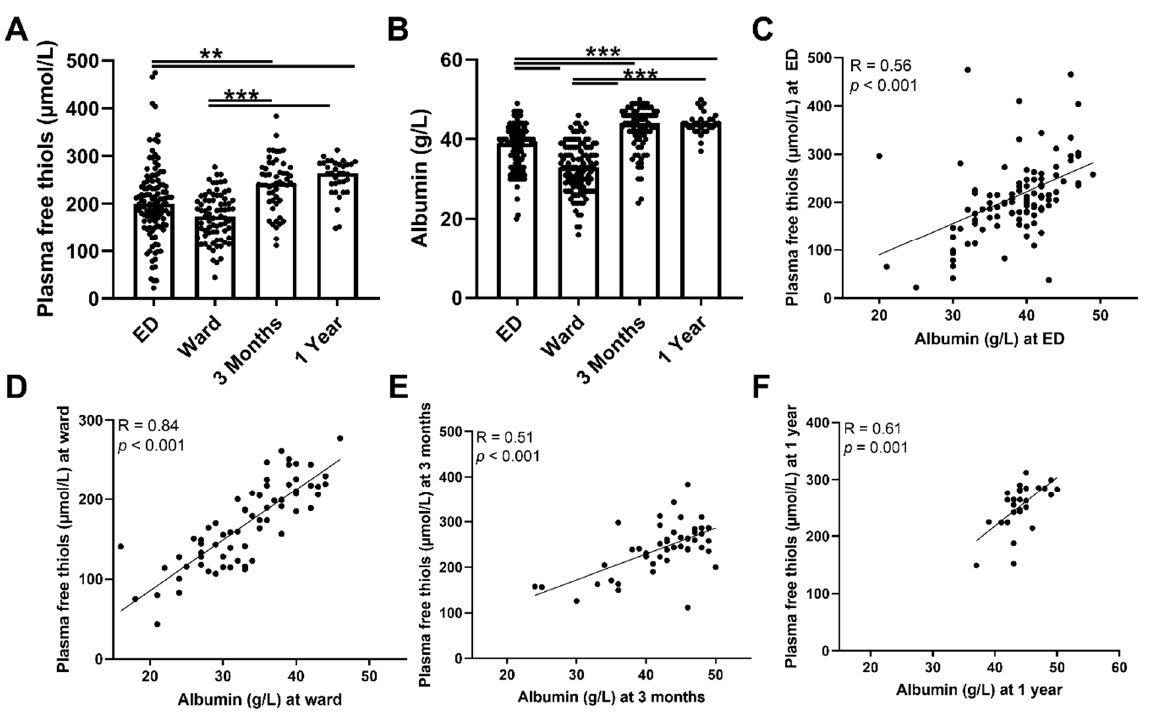
Figure 2. Course of plasma free thiols in patients with sepsis and correlations with albumin. ( A ) Plasma free thiols at the ED, the ward, and at three months and one year after hospital admission. ( B ) Albumin levels at the ED, the ward, and at three months and one year after hospital admission. ( C ) Correlation of plasma albumin at the ED and plasma free thiols at the ED. ( D ) Correlation of plasma albumin at the ward and plasma free thiols at the ward. ( E ) Correlation of plasma albumin at three months and plasma free thiols at three months. ( F ) Correlation of plasma albumin at one year and plasma free thiols at one year. Statistical analyses were performed using Wilcoxon matched-pairs signed test. Bars represent the median; dots represent individual levels. ** means p < 0.01 and, *** p < 0.001. ED: emergency department.